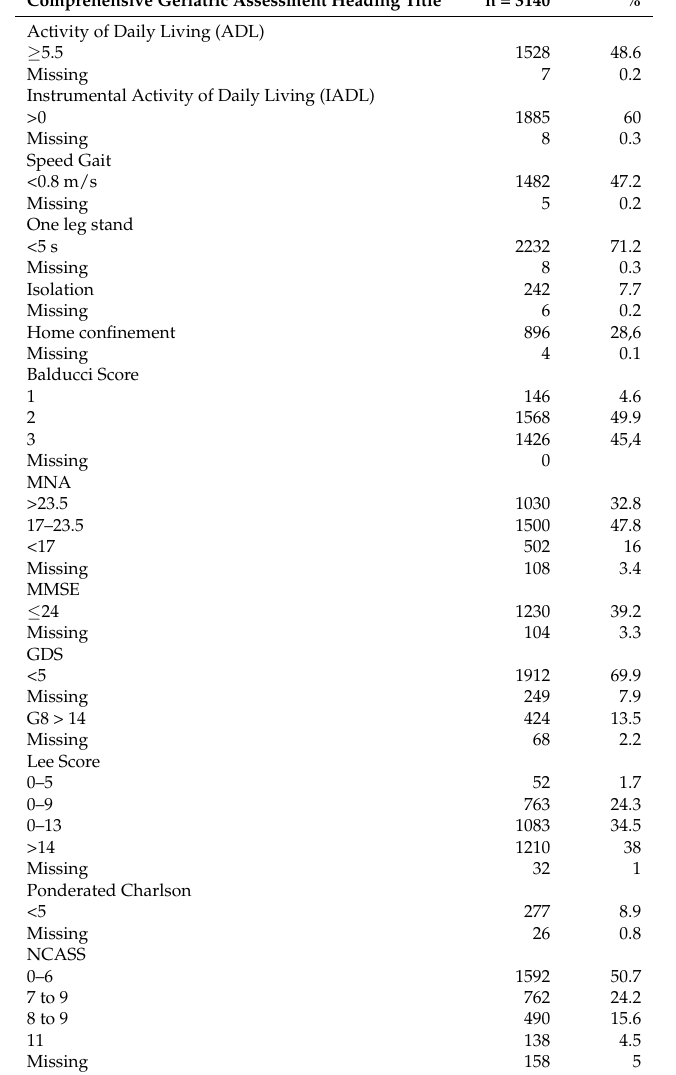
Table 2. Comprehensive geriatric assessment (CGA) at